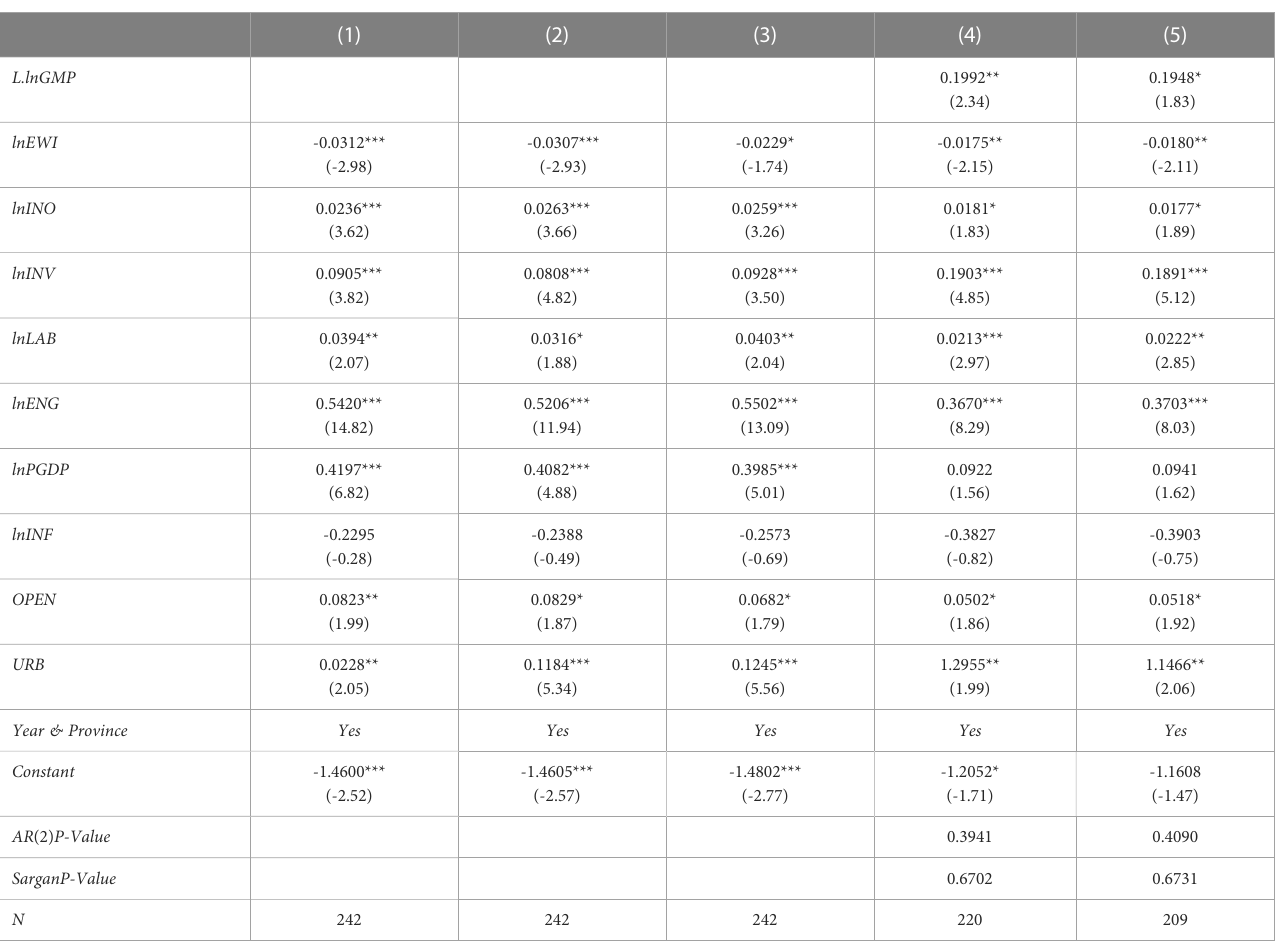
TABLE 1 Panel regression analysis